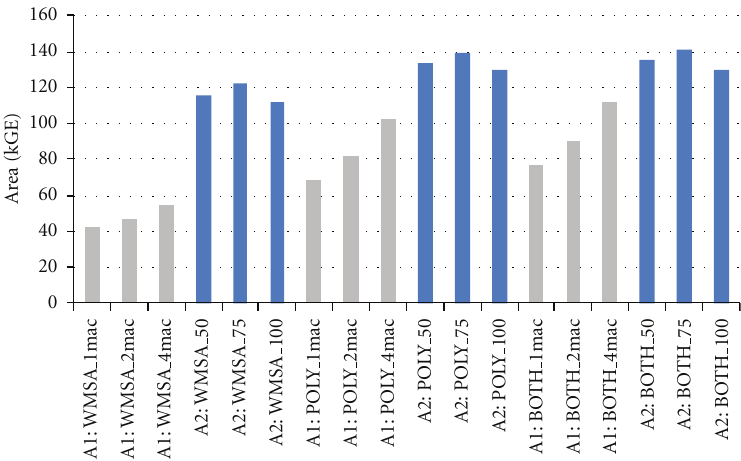
Figure 20: Area across all A1 and A2 design points for 32-bit designs.